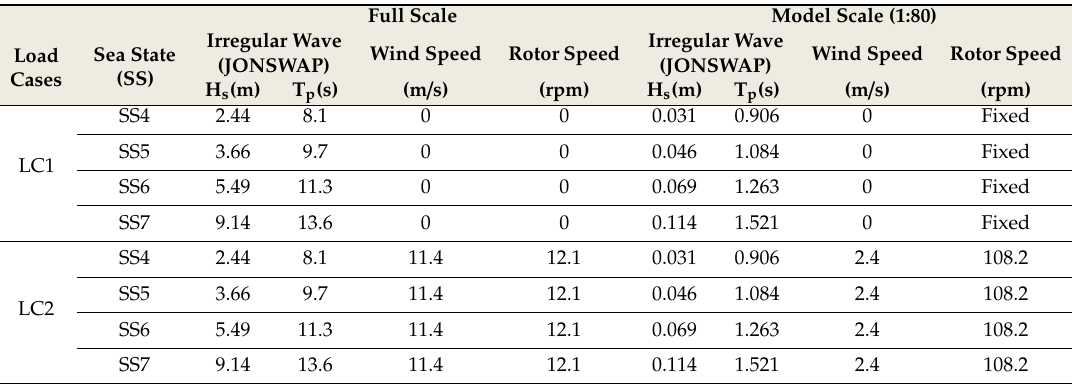
Table 4. Environmental conditions and wind turbine operational status of LC1 and LC2.